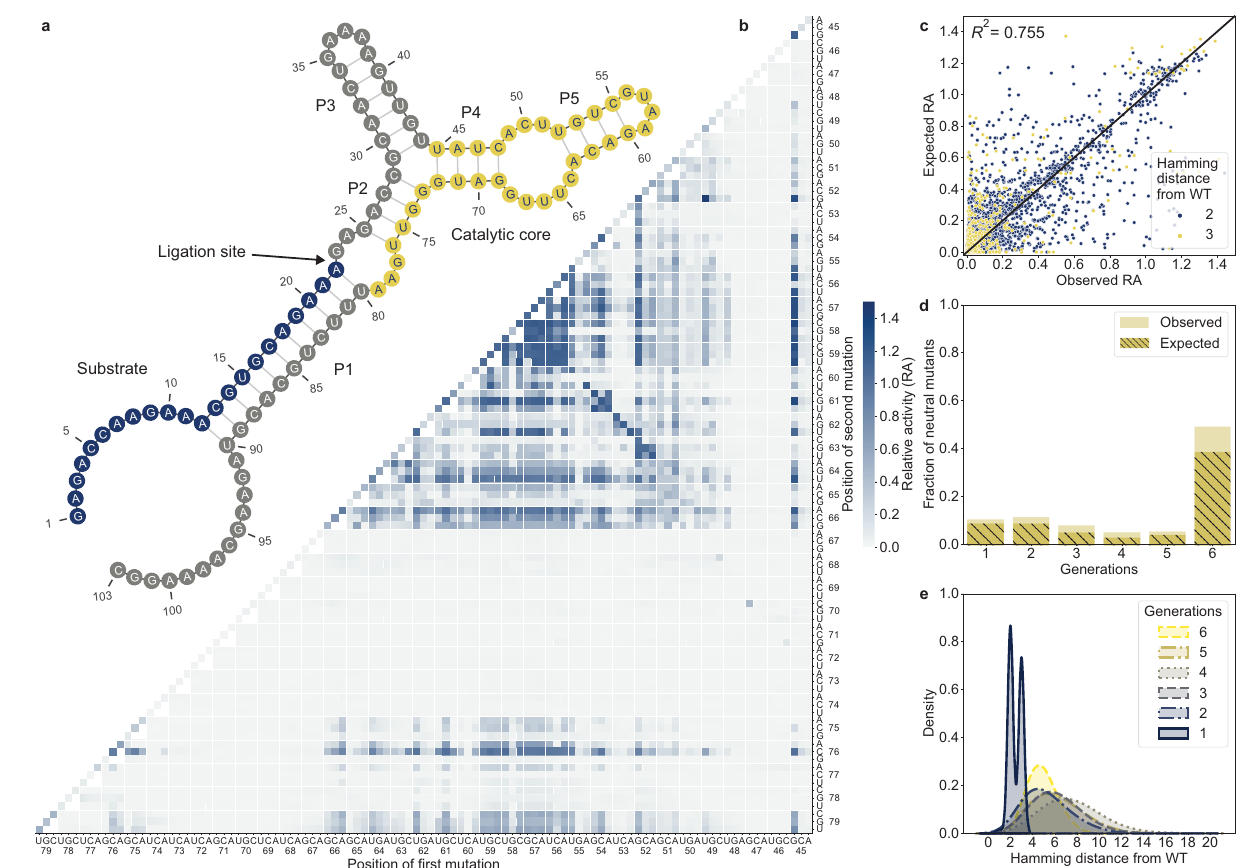
Fig. 2 | Exploring the fi tness landscape of F1*U with high-throughput experi- mental screening and in silico genetic processes. a Predicted secondary struc- ture of the ligated F1*U ligase ribozyme by ViennaRNA 2.5.1 software. The mutated regions consist of the 35 nt catalytic core from U45 to A79 (yellow). The arrow denotes the ligation site. The ligated substrate is depicted in blue. b RA of single (diagonal)anddoublemutantsoftheF1*Uligasecatalyticcore. c ObservedRAfrom generation 1 compared to the expected RA calculated from the constituent single